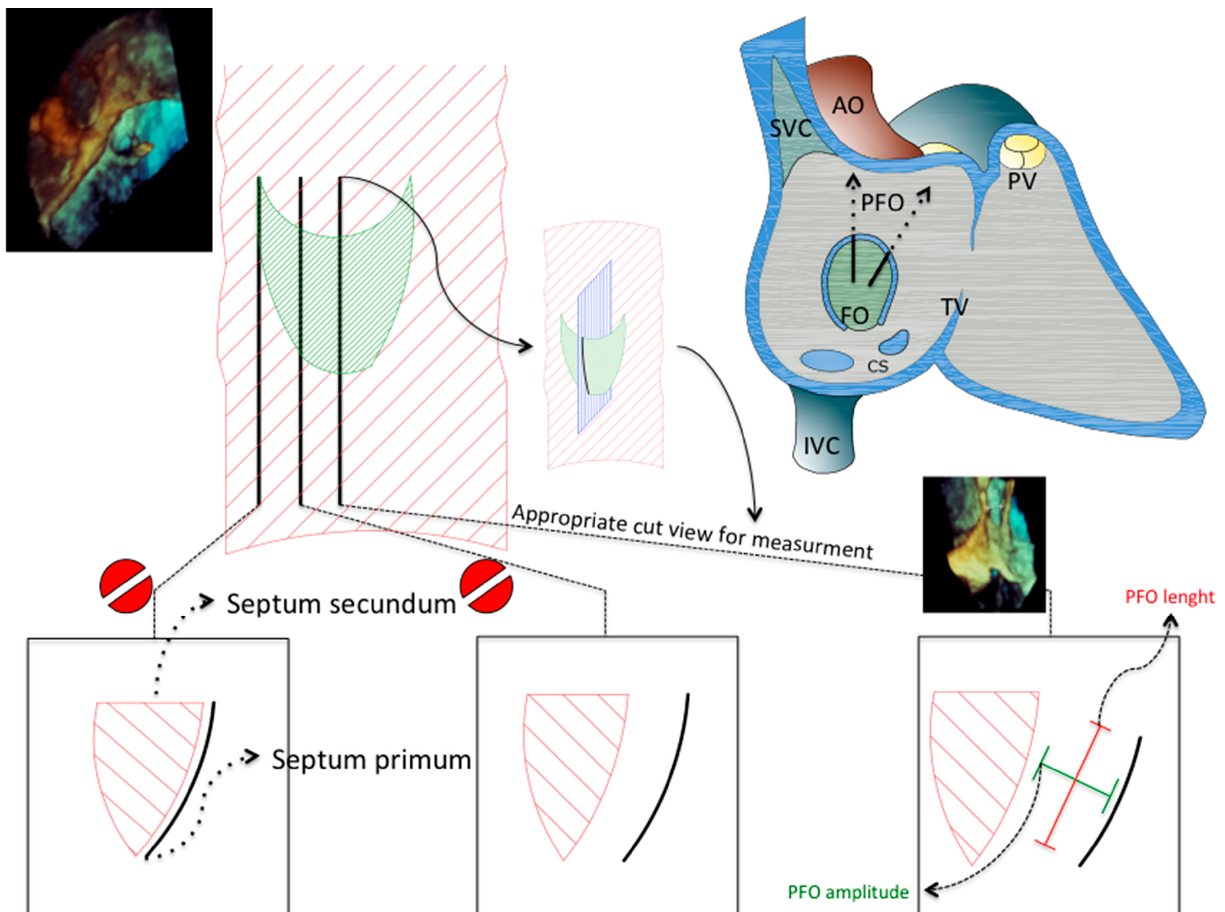
Figure 2. Anatomy of PFO. Detailed anatomy of PFO tunnel is presented. Three different cross-section planes are shown located at three different levels of septum primum. Due to the particular anatomy of septal attachment, central plane should be used for procedural measurement of PFO amplitude and length for proper device selection. Selected three-dimensional TEE left atrial view of PFO and appropriate cut for PFO amplitude measurement are presented. AO = AOrta; CS = Coronary Sinus; FO = Fossa Ovalis; IVC = Inferior Vena Cava; PFO = Patent Foramen Ovale; PV = Pulmonary Valve; SVC = Superior Vena Cava; TEE = Trans-Esophageal Echocardiography; TV = tricuspid valve.